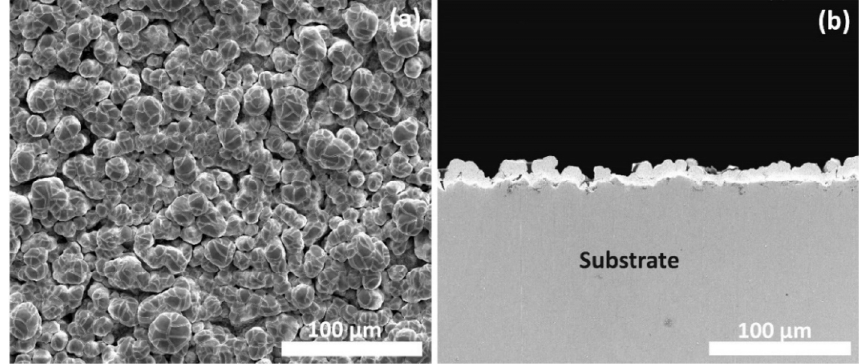
Fig. 1 SEM characterization of LHE Cd coating: (a) surface morphology and (b)